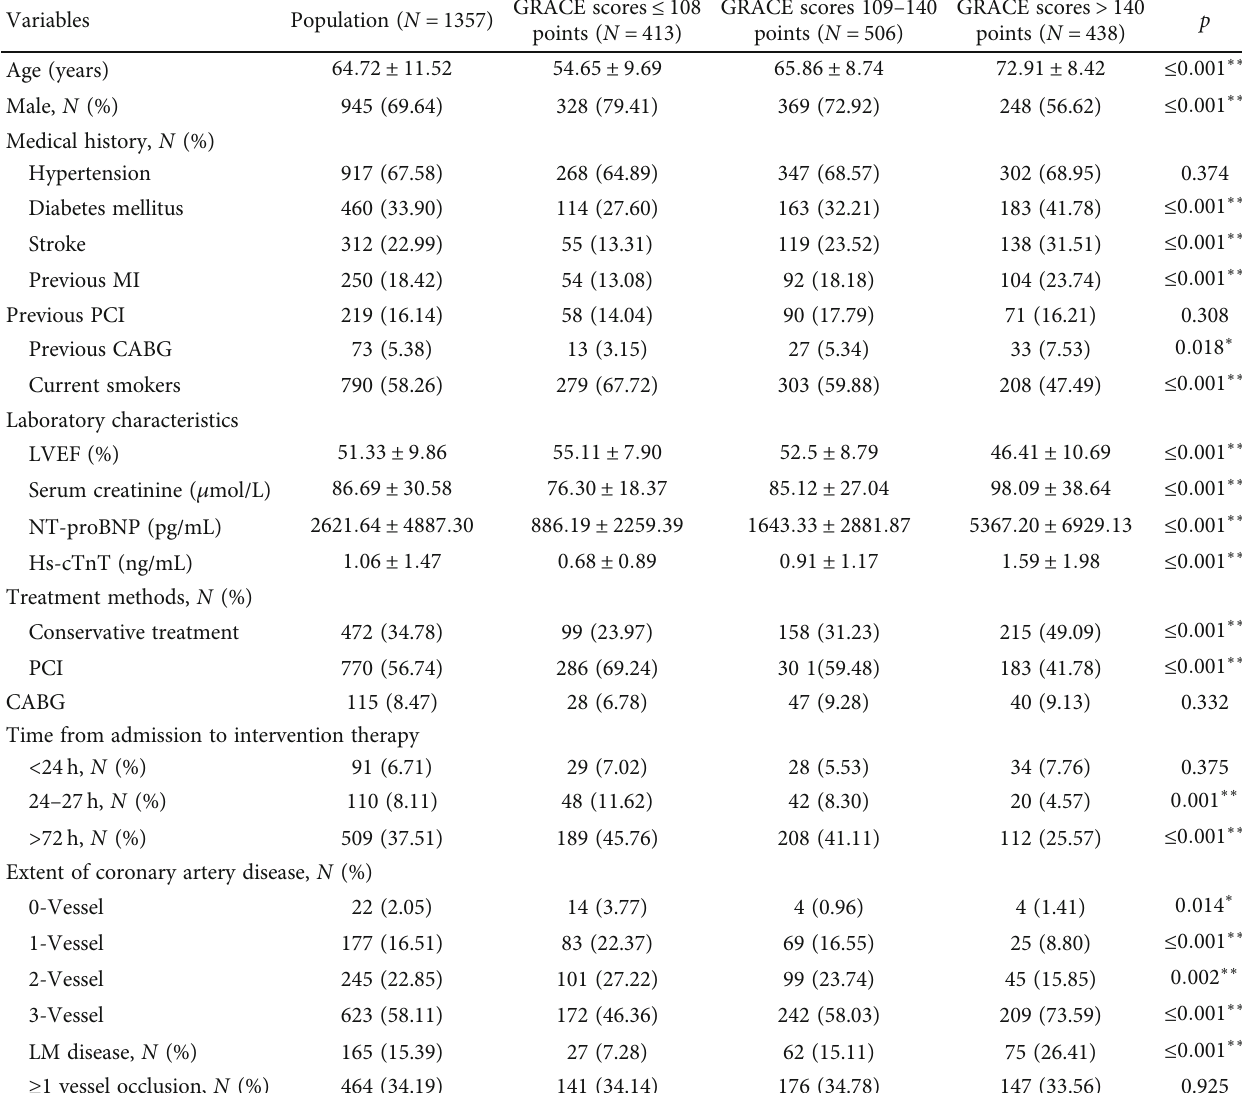
Table 1: Baseline